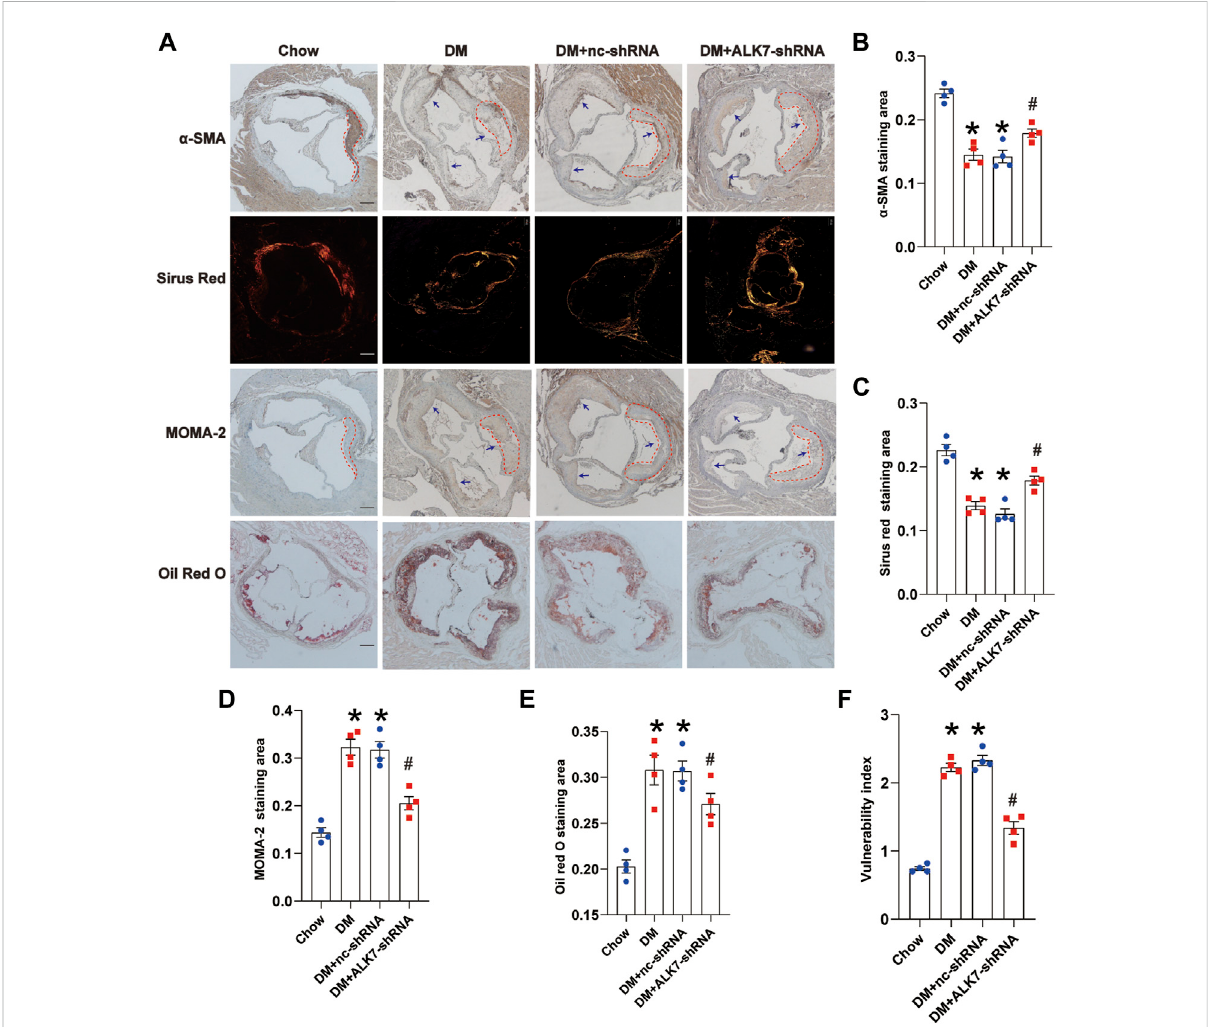
FIGURE 3 KnockdownofALK7increasedatheroscleroticplaquestabilityofdiabeticmice. (A) .Thestabilityofatheroscleroticplaquesintheaorticrootwas determined by α -SMA for smooth muscle cells, picrosirius red staining for collagen, MOMA-2 for macrophage in fi ltration, and Oil Red O staining for lipid deposition. n = 4 per group. Scale bar: 100 μ m. Dashed lines encircled some part of atherosclerotic plaque. Arrows indicated all the atherosclerotic plaques in the aortic root. (B – E) . Quanti fi cation of smooth muscle cell content, collagen content, macrophage in fi ltration and lipid accumulation in the atherosclerotic plaques of aortic root. (F) . The vulnerability of atherosclerotic plaques was calculated using the ratio of MOMA-2 + (%) plus Oil Red (%) to α -SMA (%) plus collagen (%). Data was analyzed with ANOVA. * p < 0.05 vs. the Chow group, # p < 0.05 vs. the DM + nc-shRNA